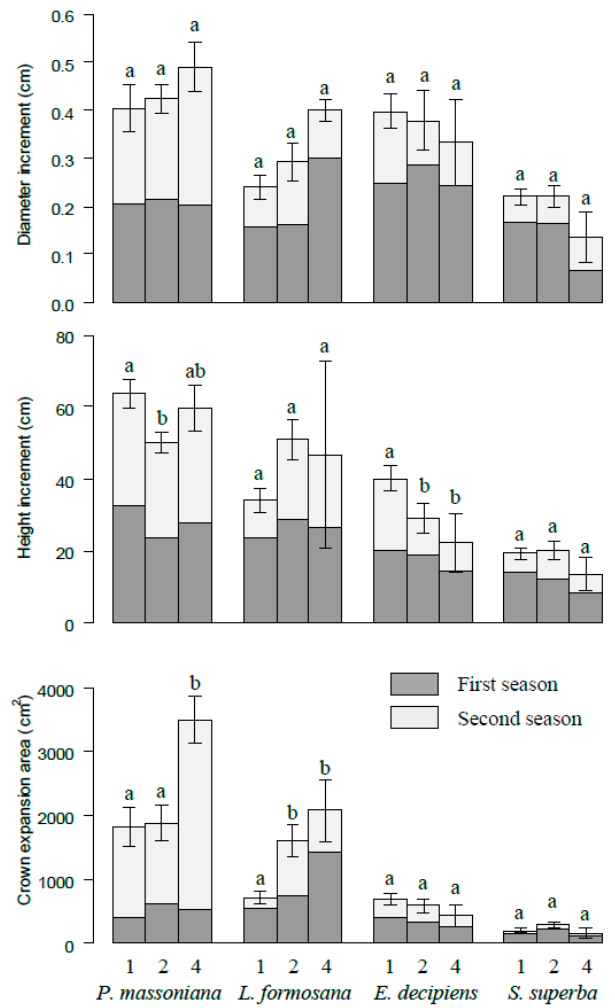
Figure 3. The increments of diameter, height, and crown projection area for P. massoniana , L. formosana , E. decipiens, and S. superba at different species richness levels. The number 1, 2, and 4 represent monoculture, two species and four species mixtures, respectively. Bars represent means ± SE. Different letters indicate significant differences among different species richness levels, p <0.05.